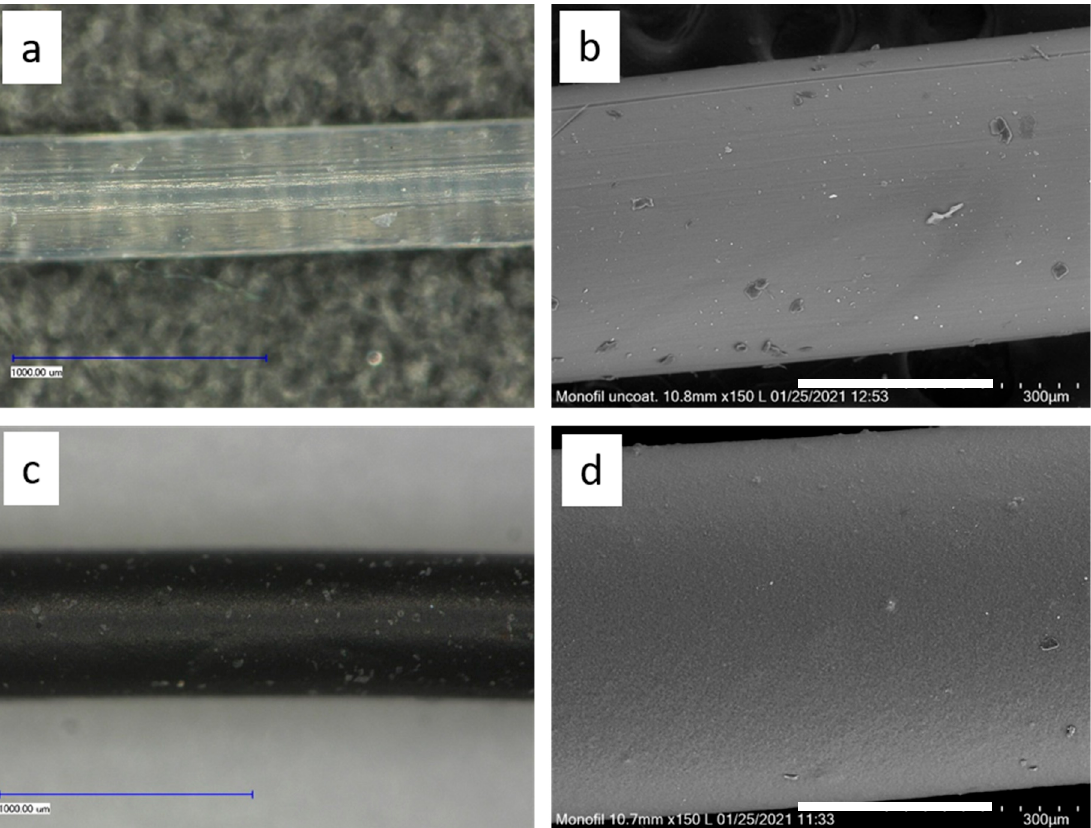
Figure 1. Photographs of the monofilament; left: Light microscopy; size bar 1 mm, right: SEM; size bar 300 µm; ( a ) and ( b ) monofilament uncoated; ( c ) and ( d ) monofilament with carbon-silicone coat- ing.